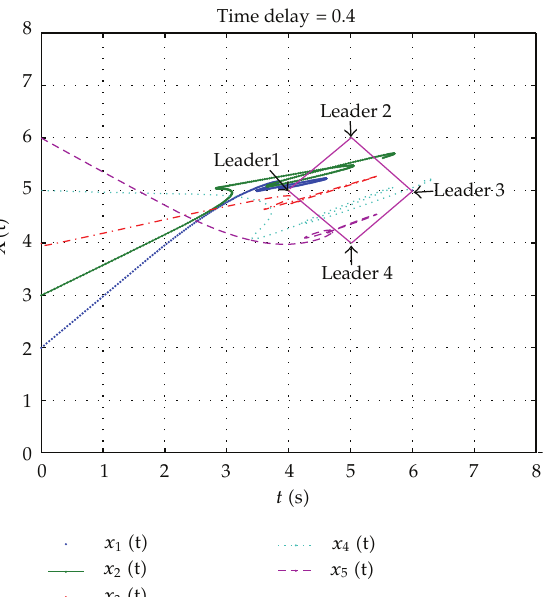
Figure 5: State trajectories of five follower agents and four leaders under the topology G 2 and time delay τ (cid:10) 0 .